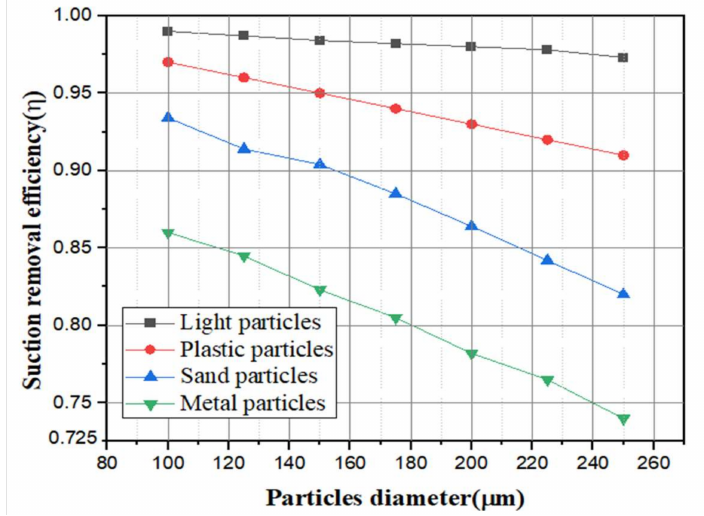
Figure 9. The results of simulating the effect of changes in particle composition and size on suction performance.